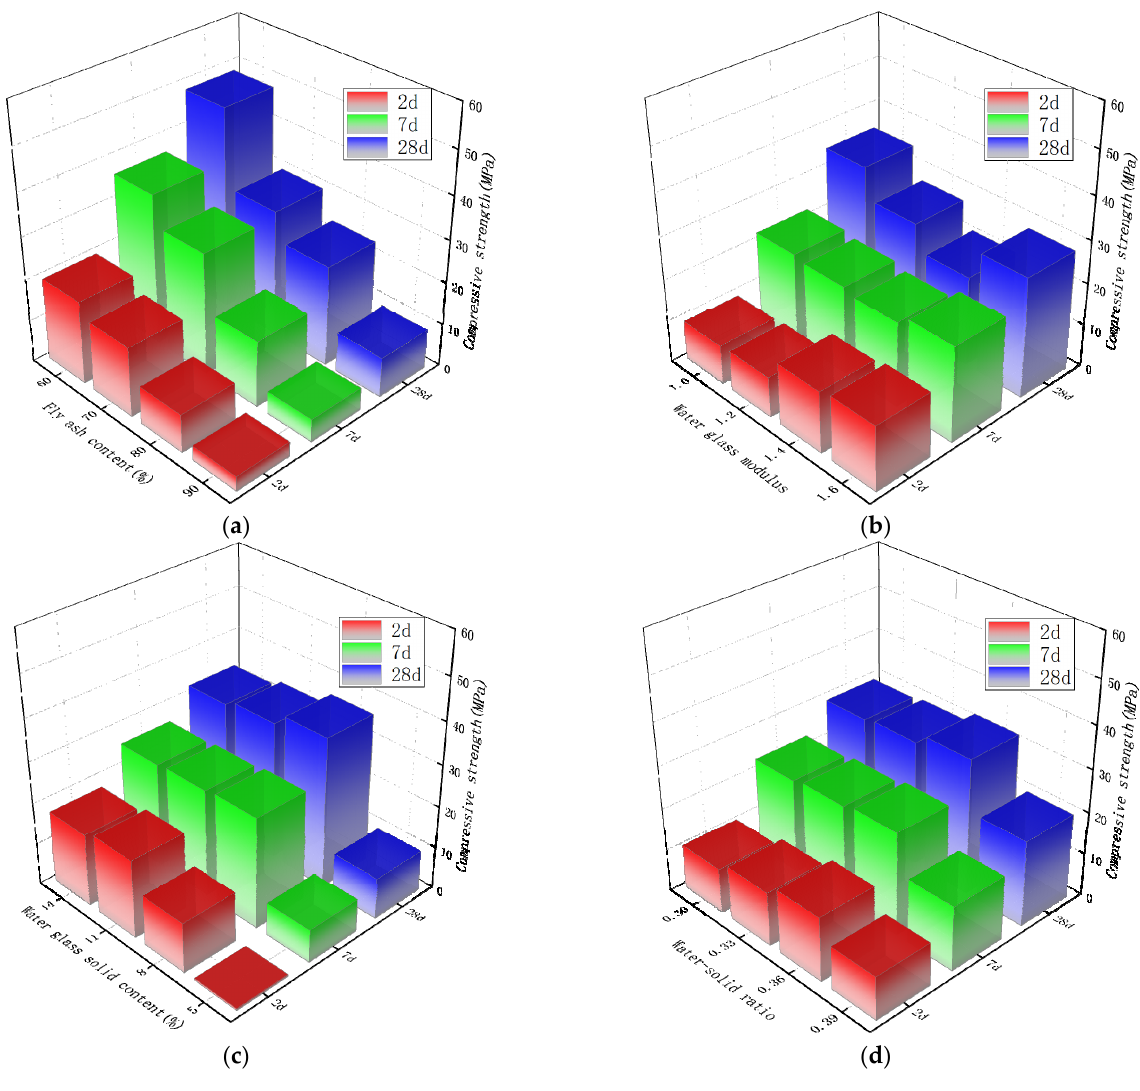
Figure 5. Influence of various parameters on the compressive strength of composite gelling system. ( a ) Influence of fly ash content. ( b ) Influence of water glass modulus on compressive strength. ( c ) Influence of water glass solid content. ( d ) Influence of water–solid ratio on compressive strength.